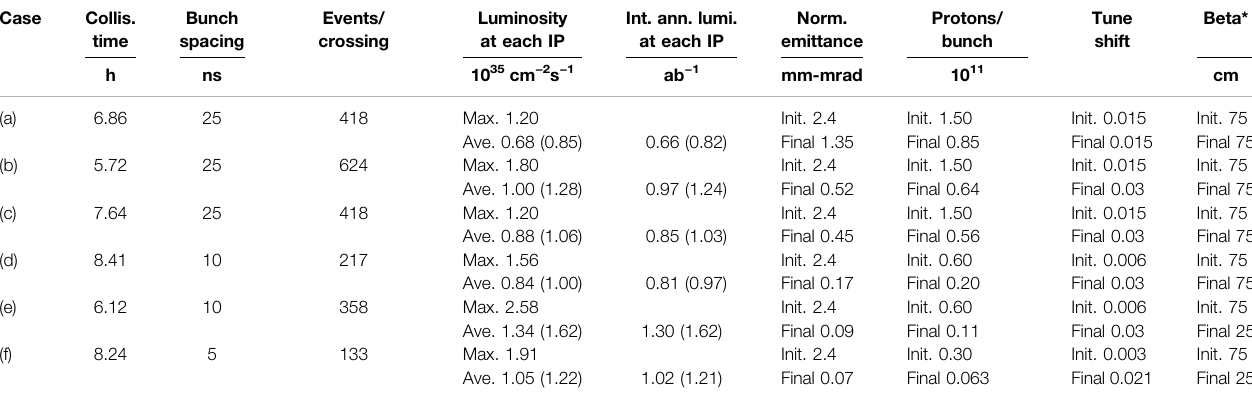
TABLE 3 | Relevant parameters during operation are summarized for six cases: (a) a fi xed tune shift; (b) allowing the tune shift to rise to 0.03; (c) as in (b) but leveling the luminosity to its initial value; (d) as for (c) but with bunch spacing of 10 ns; (e) as for (d) but reducing β * proportional to the emittance down to 25 cm; (f) as for (e) but with bunch spacing of 5 ns. All values are for run times maximized for a turnaround time of 2.4 h, except for the parenthesized average luminosities and integrated annual luminosities that are for a turnaround time of 0.81 h. Case Collis. Bunch Events/ Luminosity time spacing crossing at each